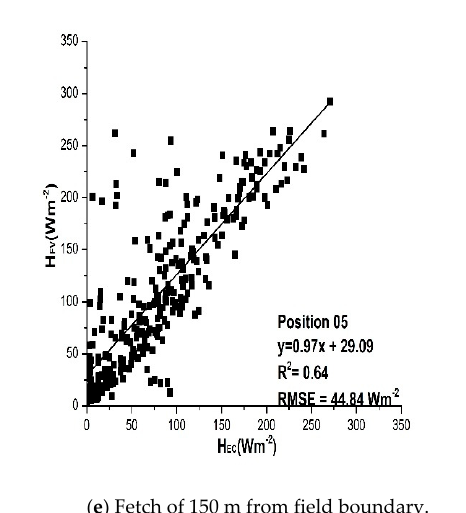
Figure 6. ( a ) Fetch of 170 m from field boundary; ( b ) Fetch 165 m from the field boundary; ( c ) Fetch of 160 m from field boundary; ( d ) Fetch of 155 m from field boundary; ( e ) Fetch of 150 m from field boundary. Regression analysis between the estimated H FV and measured H EC at five different positions along the fetch.